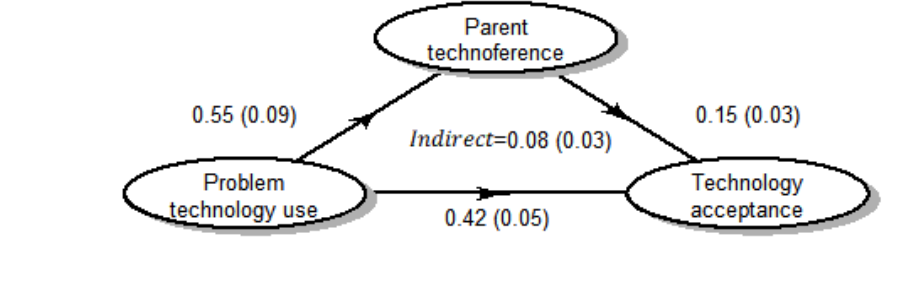
Figure 1. Results of the mediation analysis. Mean effect sizes and SDs are